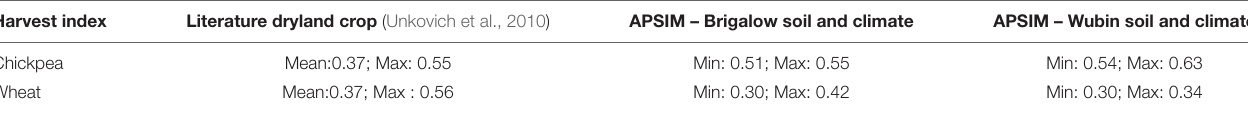
TABLE 5 | Comparison of harvesting index between APSIM simulations and literature. Harvest index Literature dryland crop (Unkovich et al.,